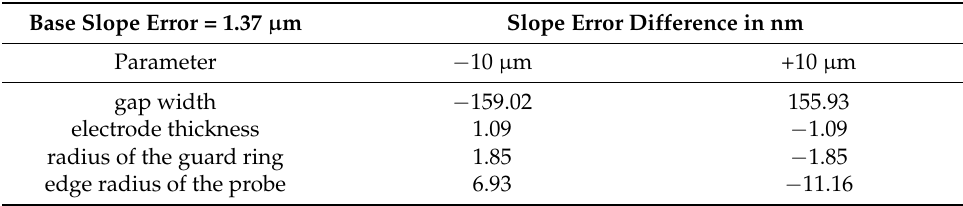
Table 1. Changes in the slope error depending on the sensor parameters for a given manufacturing tolerance of ± 10 µ m.